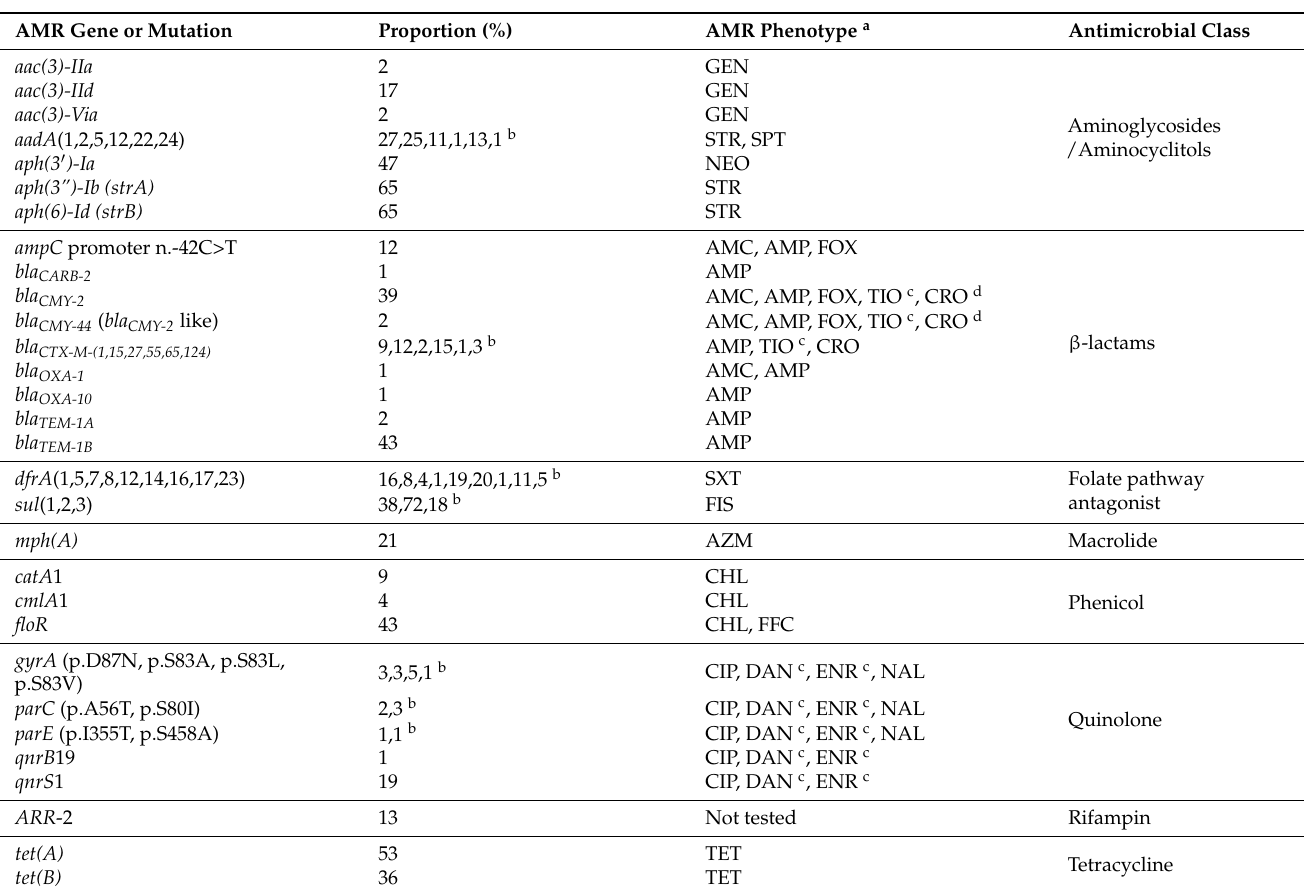
Table 2. Proportion positive for AMR genes or AMR-associated mutations with their related pheno- typic resistance among a selection of the most resistant Escherichia coli ( n = 118) isolated from manure from 101 dairy farms in Qu é bec,